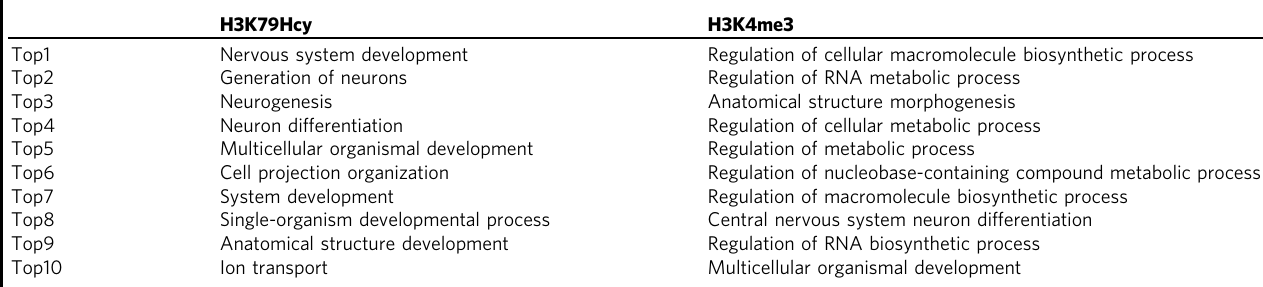
Table 1 Top 10 of modi fi cation binding genes analyzed by biological process Gene Ontology H3K79Hcy H3K4me3 Top1